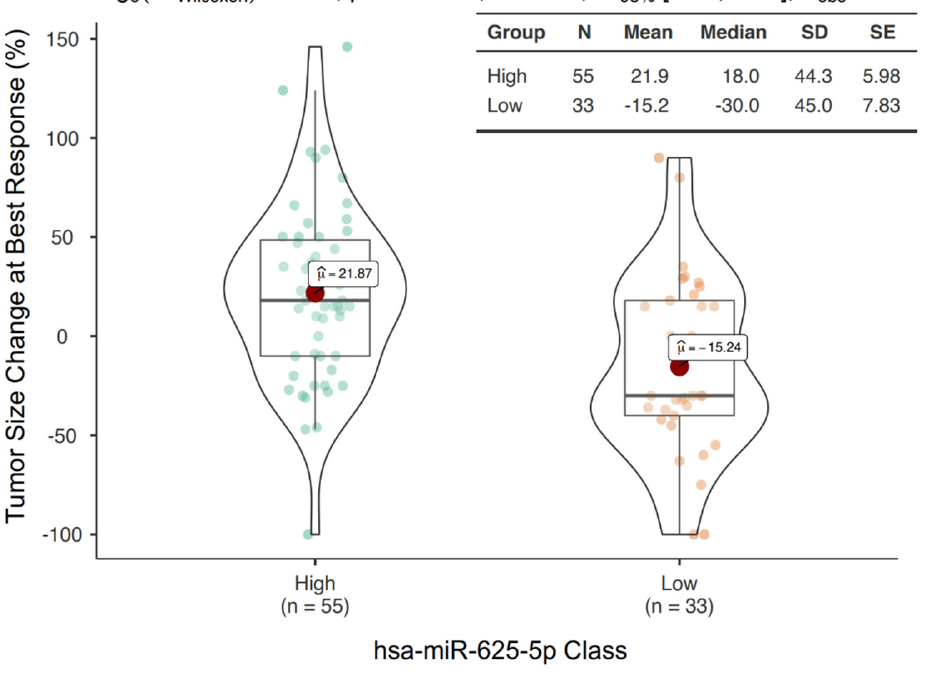
Figure 2. Tumor size changes according to miR-625-5p expression. Box/Violin plot representing the tumor size change at best response in miR-625-5p High and Low